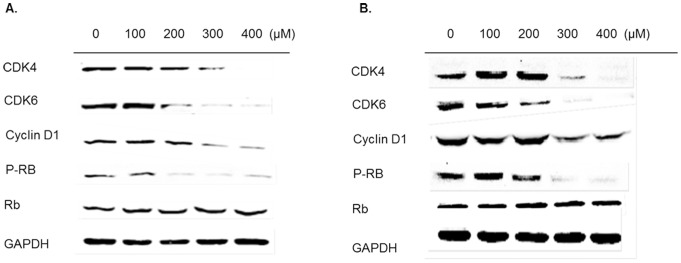
The expression of cell cycle related proteins in vitro.Key proteins related to cycle regulation were detected by WB. As I3C concentration increased, cyclin D1, CDK4, CDK6 and pRb protein expression in 5-8F(A) and CNE2(B) cell line were down-regulated. The data are presented as the mean± SEM.